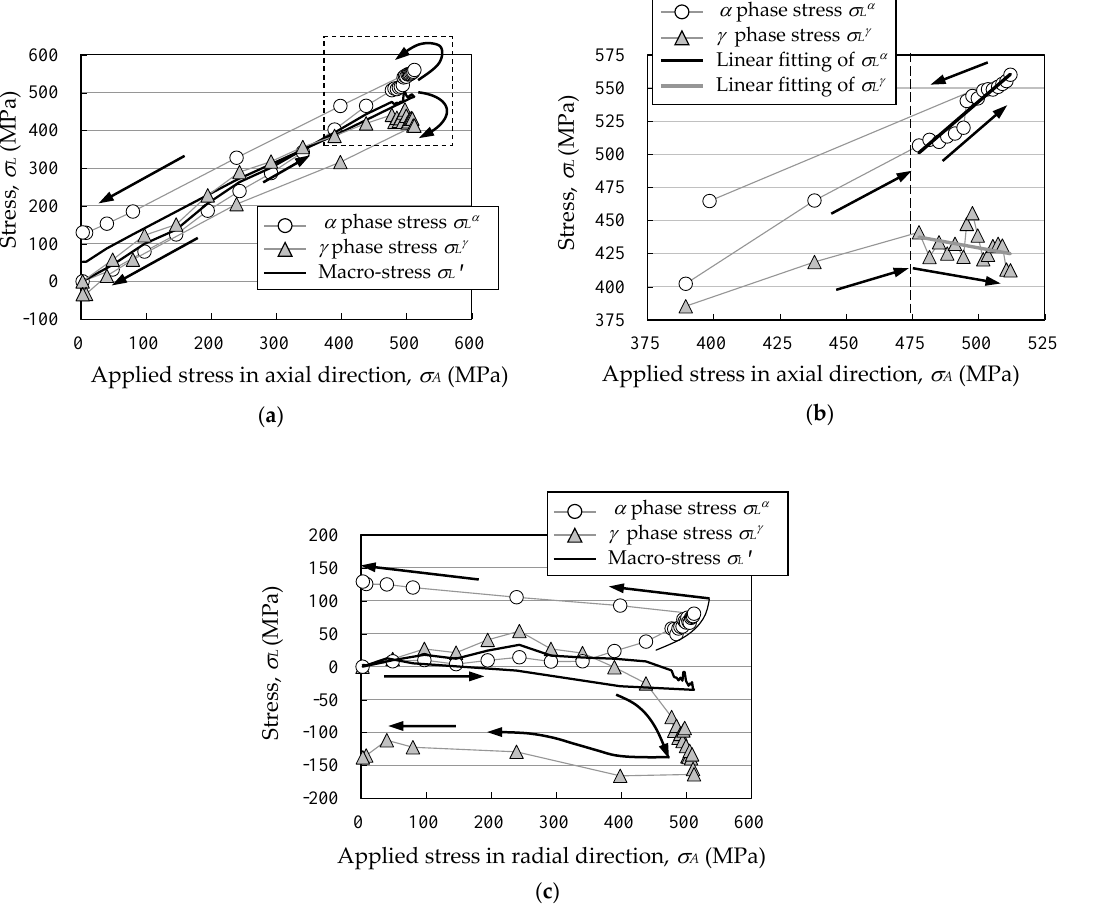
Figure 13. Phase stress evolution under tensile loading. ( a ) Axial direction, ( b ) Enlargement of the area with broken lines in ( a ), ( c ) Radial direction.